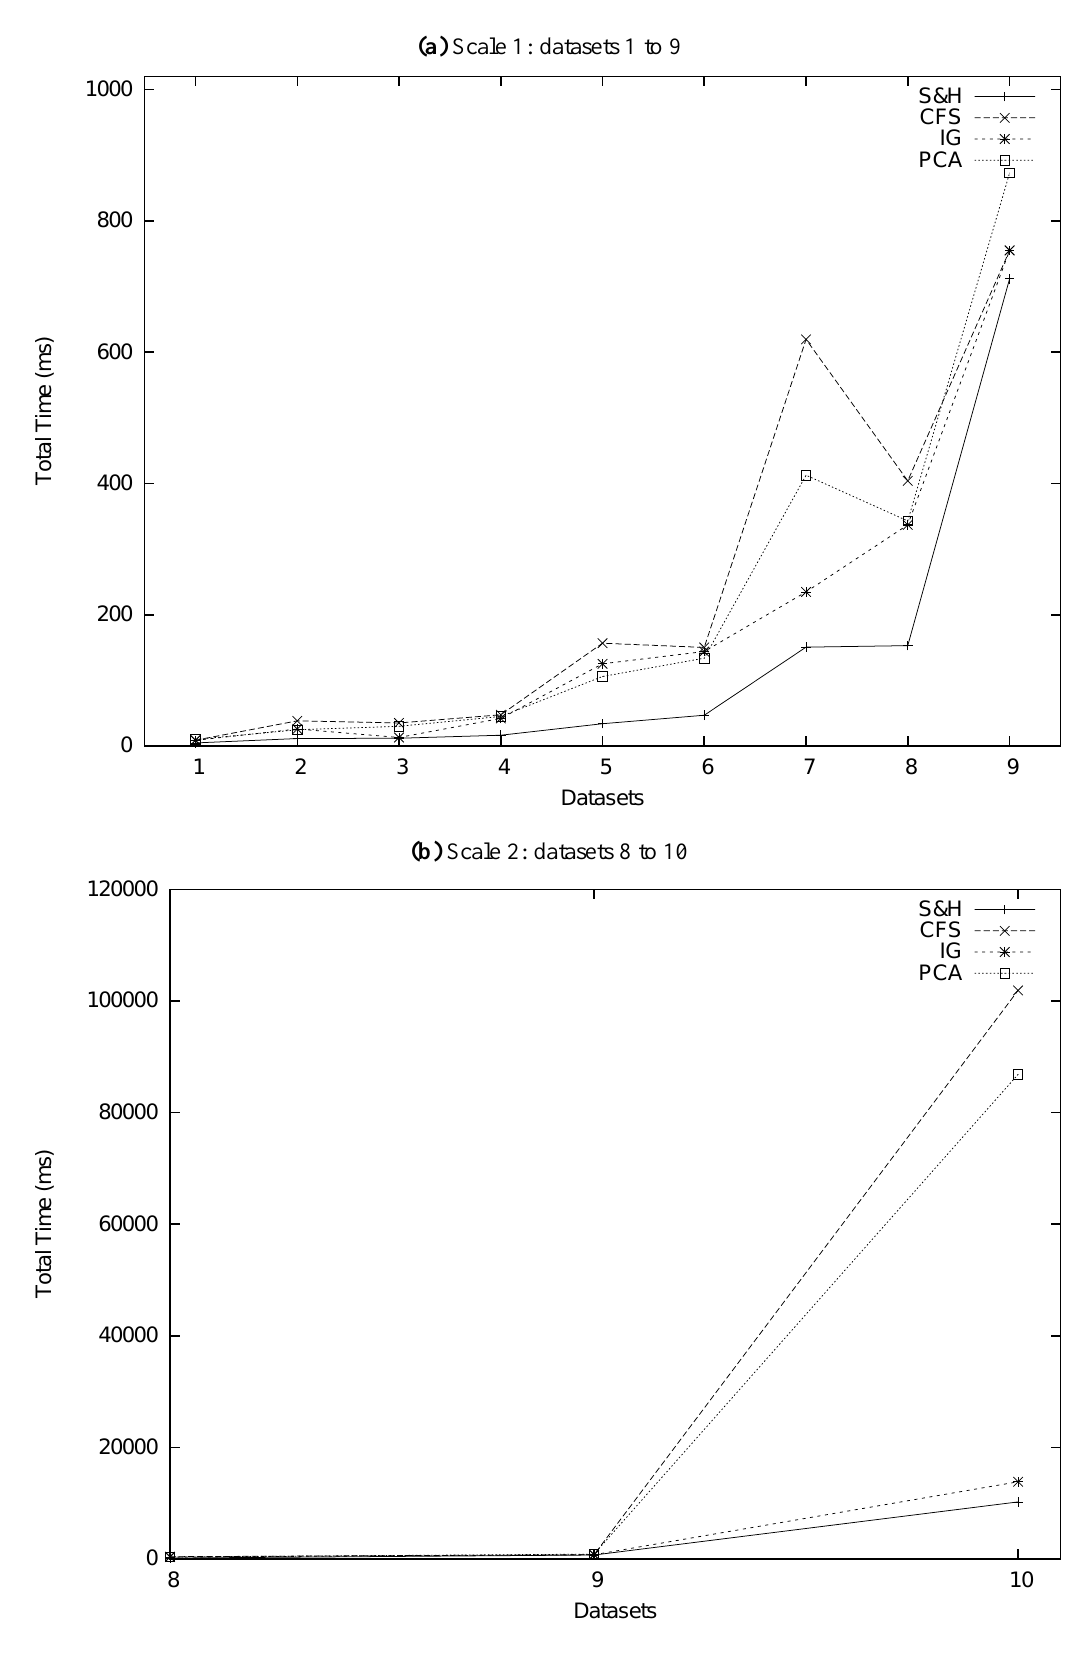
Figure 19. Total time comparisons. In this figure, dataset sequence numbers denote ecoli, wdbc, sonar, yeast, segment, segmentation, waveform, sensor, magic, isolet sequentially. (a) Scale 1: datasets 1 to 9